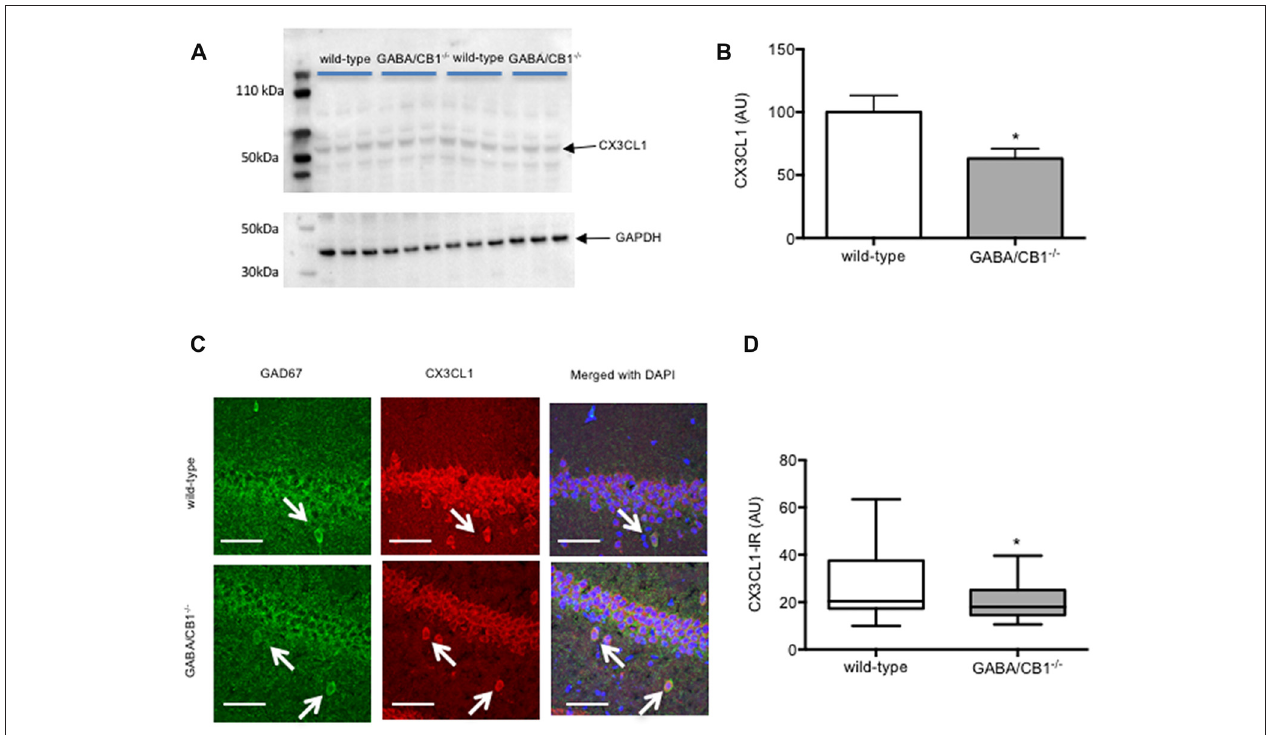
FIGURE 6 | (A) Representative images of CX3CL1 and glyceraldehyde-3-phosphate dehydrogenase (GAPDH) immunoblots of hippocampal samples from control WT and GABA/CB1 − / − mice. (B) Western blot analysis of hippocampal CX3CL1 levels using control WT and GABA/CB1 − / − mice. ∗ p < 0.05 using Student’s t -test; n = 9. (C) Representative microphotograph of confocal images of GAD67 (green) and CX3CL1 (red) colocalization. Scale bar represents 50 µ m. White arrows point to GAD67-positive GABAergic neurons. (D) CX3CL1 immunoreactivity in GAD-67-positive GABAergic neurons in the hippocampus of saline-treated WT and GABA/CB1 − / − mice. ∗ p < 0.05 using Mann-Whitney test; n =